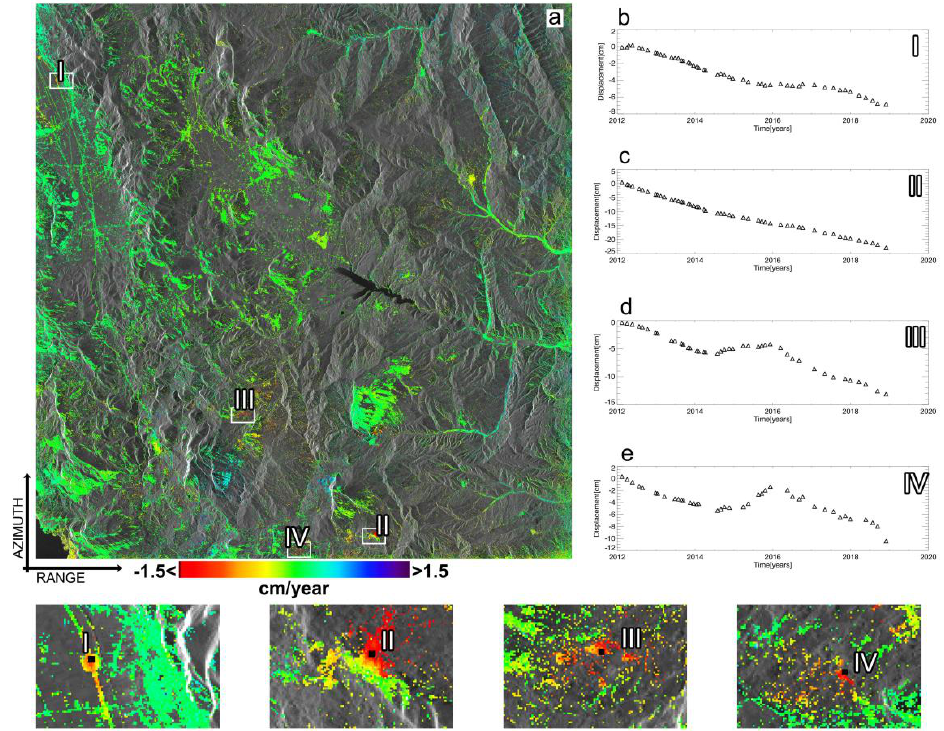
Figure 11. WAVE approach InSAR products. ( a ) Mean displacement velocity map of the investigated area. Four SAR pixels, labelled as I, II, III, and IV have been selected. The relevant ground displacement time-series are shown in ( b – e ), whereas the zoomed views of the areas nearby the selected pixels are also shown. Note that the time-series of pixel III and IV are characterized by 42 and 40 acquisition times, respectively. Sensors 2020 , 20 , x FOR PEER REVIEW